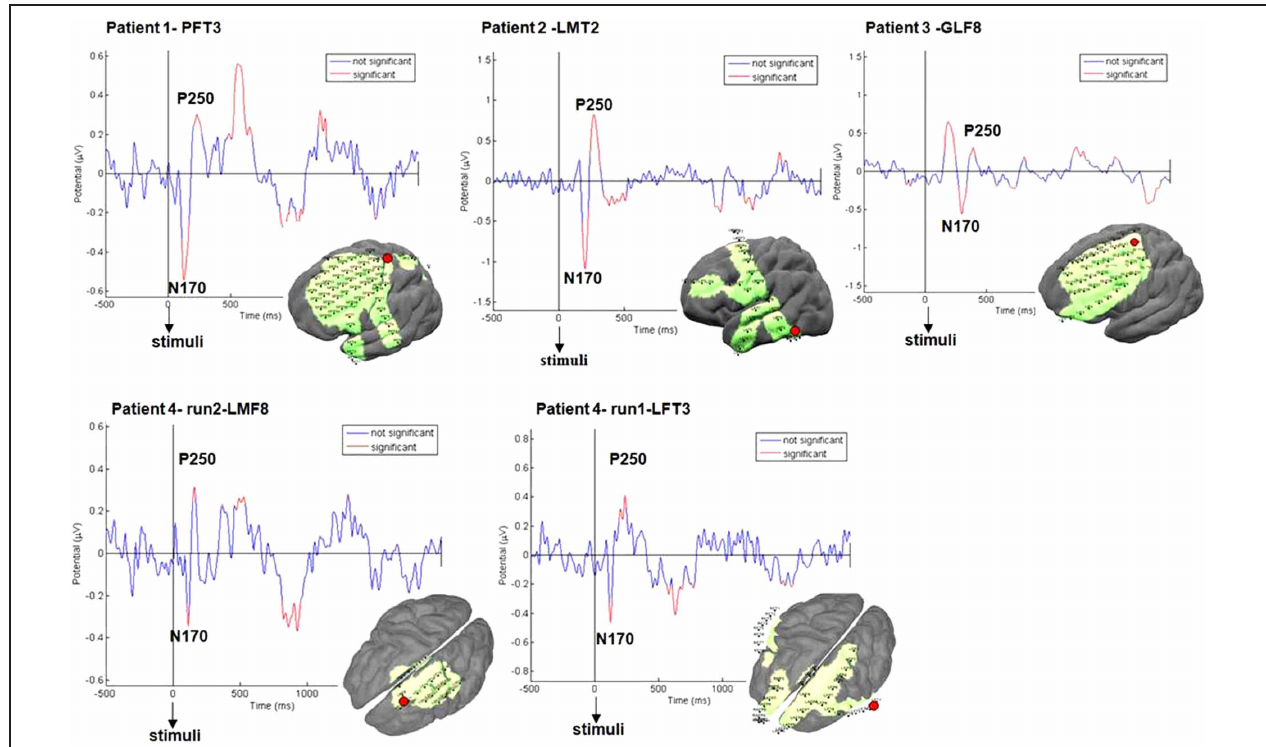
FIGURE 6 | ERPs validation. ERPs evoked by stimulus showed typical N170, P250 peaks. Significant peaks are marked in red ( p < 0 . 05). Examples are shown for each patient for one representative electrode in fronto-parietal regions (marked in red) for all conditions.